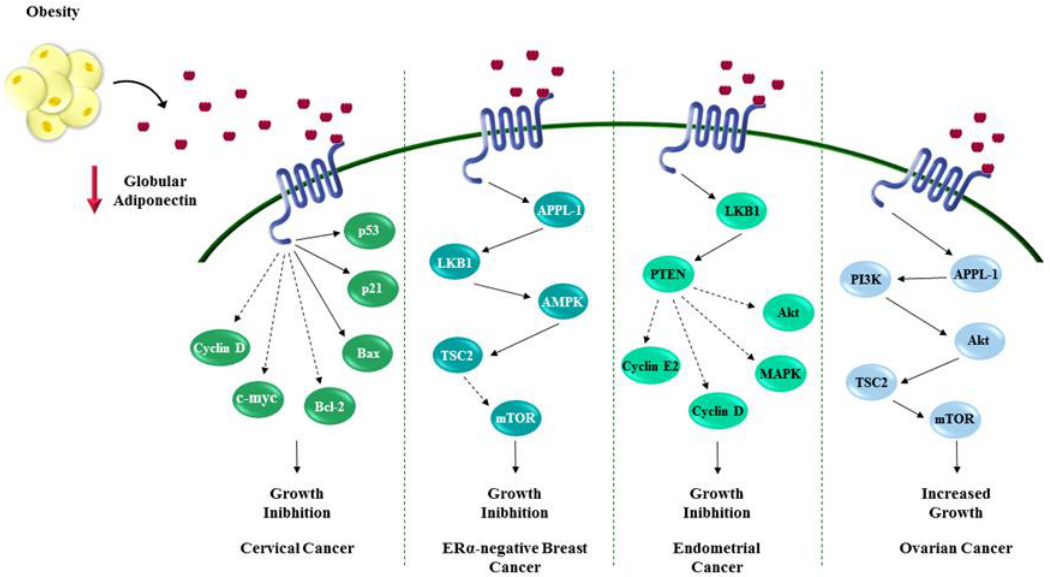
Figure 2. Role of adiponectin in influencing female cancers. Adiponectin, the most abundant secreted adipokine, heavily impacts the proliferation of cancer cells through several mechanisms that seem to be tumor-specific. Mainly adiponectin exerts its effects regulating cell cycle and apoptosis. The red ↓ indicates a reduction of globular adiponectin concentration. Dotted arrows show inhibition of downstream protein activation. Solid arrows mark activation of downstream proteins.